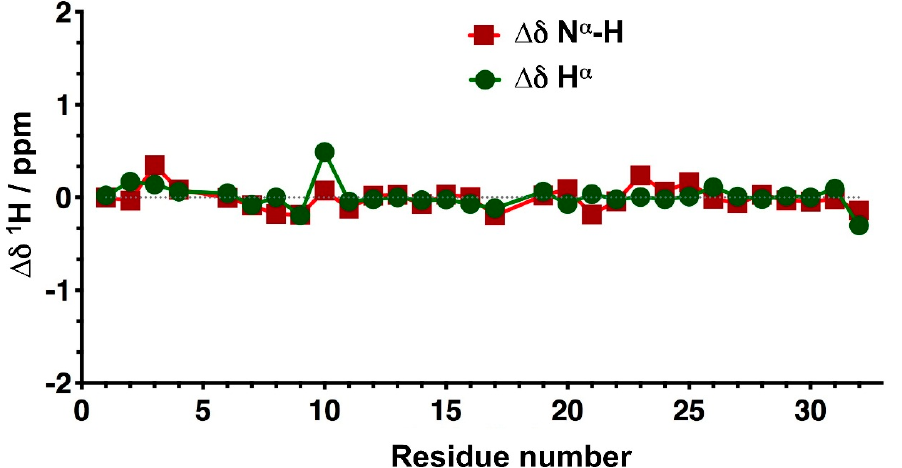
Figure 3. 1 H-NMR characterization of folded cyclotide MCo-AT1-7. Chemical shifts differences of the backbone, N α -H and H α protons between the common sequence (residues 1 through 32) of MCoTI-I and MCo-AT1-7 (Table S1).